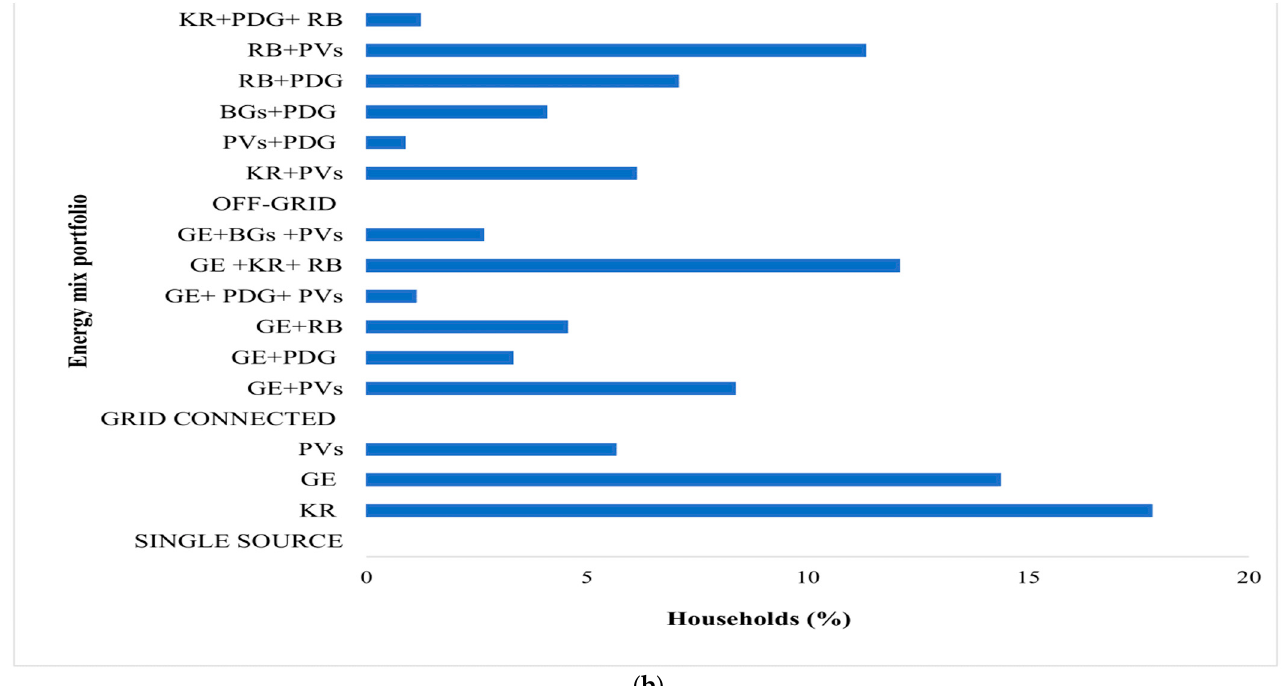
Figure 2. Proportion of sample households’ energy fuel mix. ( a ) Cooking energy mix. ( b ) Lighting energy mix.